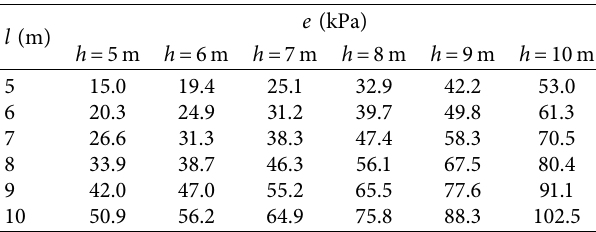
Table 4: Upper bound solution of the surrounding rock pressure e at different l and h .